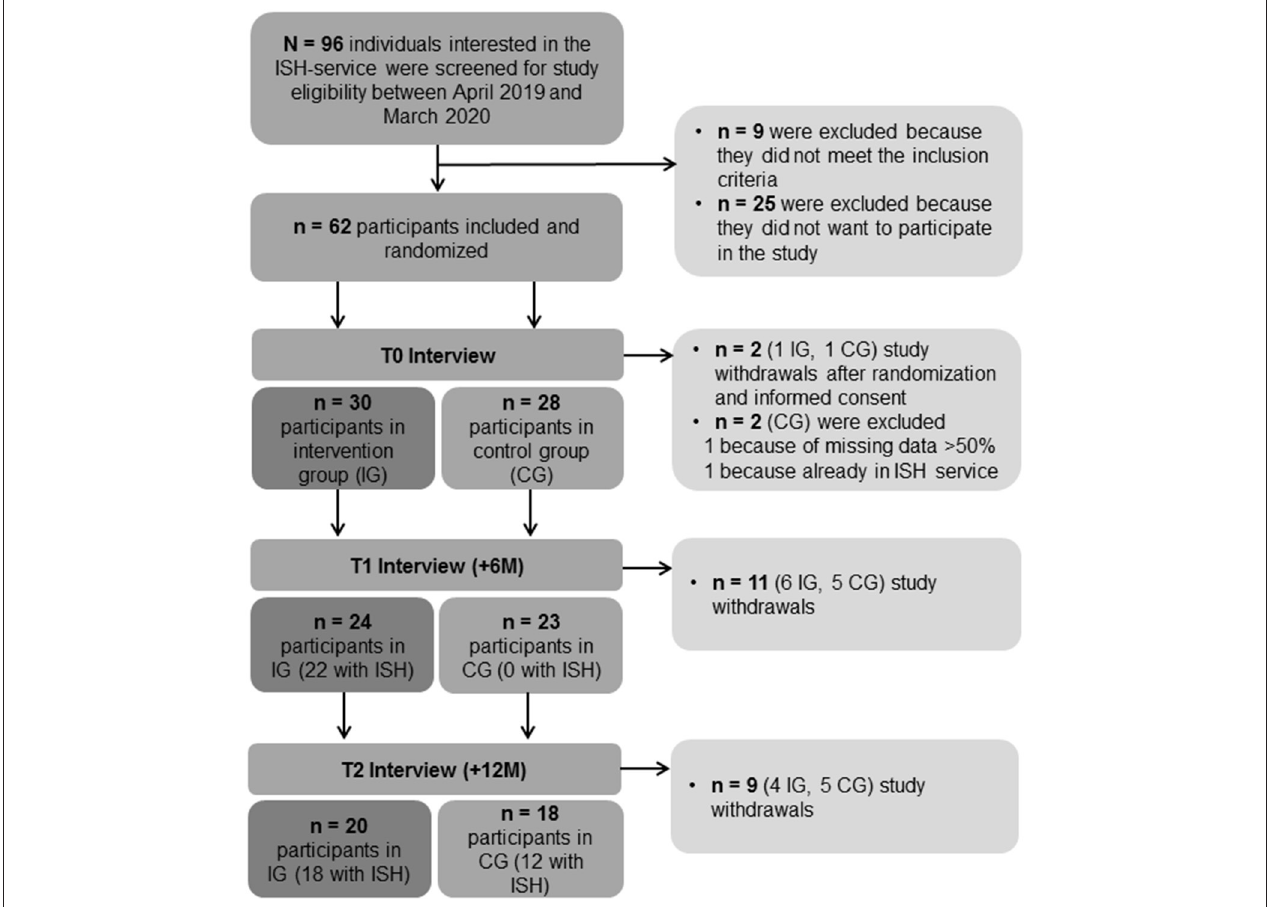
FIGURE 1 | Flowchart of the participants’ inclusion